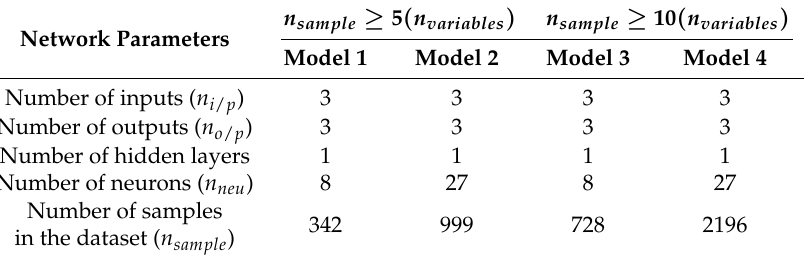
Table 5. Neural network model parameters.